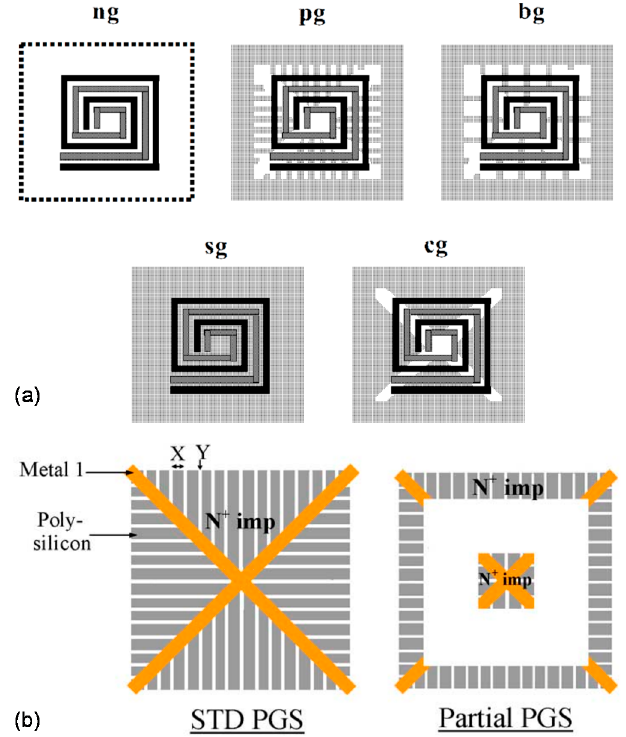
Figure 5. Various types of patterned ground shields: ( a ) Standard, complete patterned ground shield, reprinted with permission from [35]; ( b ) partially patterned ground shields, reprinted with permission from [74].